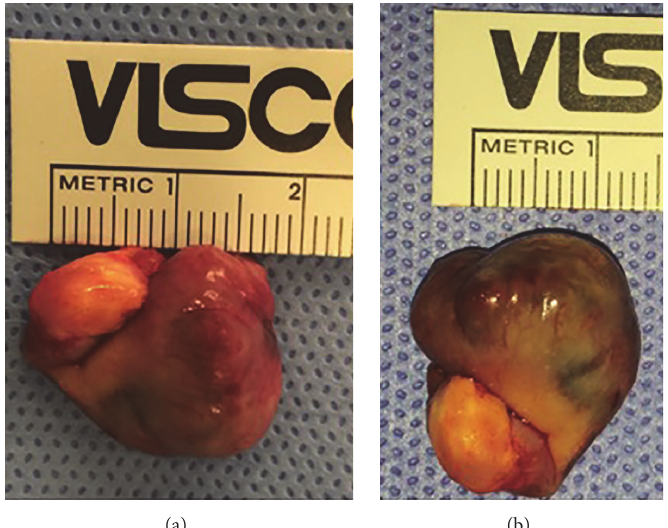
Figure 2: Gross pathology of PVNS from Case 1 (a, b), excised en bloc from the posterior-inferior aspect of the capsule and confirmed to be PVNS on formal pathological